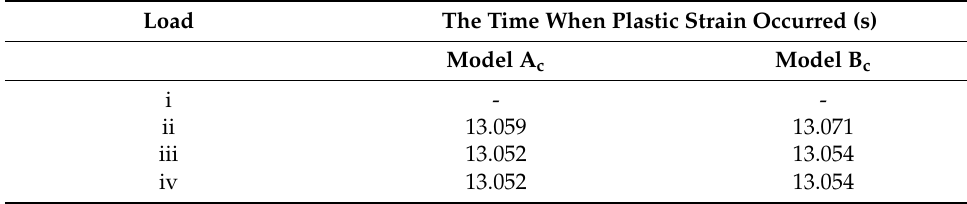
Table 3. The time when the plastic strain occurred in model A c and model B c